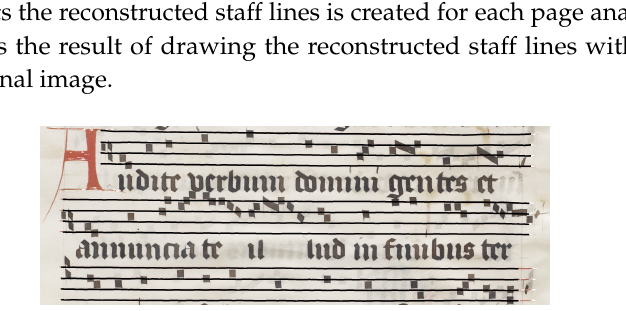
Figure 8. Reconstructed staff lines drawn over the original image analyzed. Detail of folio